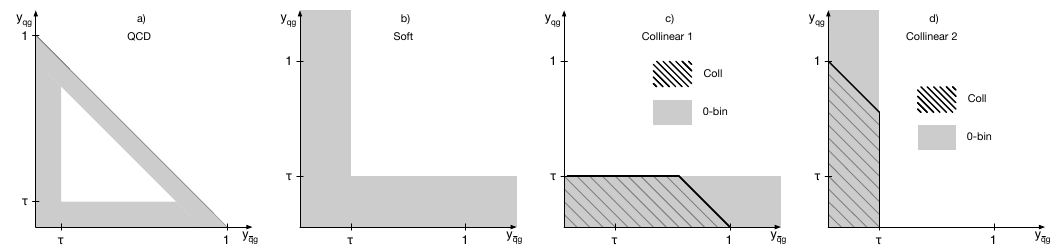
Figure 2 . The regions of phase space contributing to the various pieces. In (a) we show the phase space region of full QCD, in (b) that of the soft function, and in (c) and (d) the region of the jet